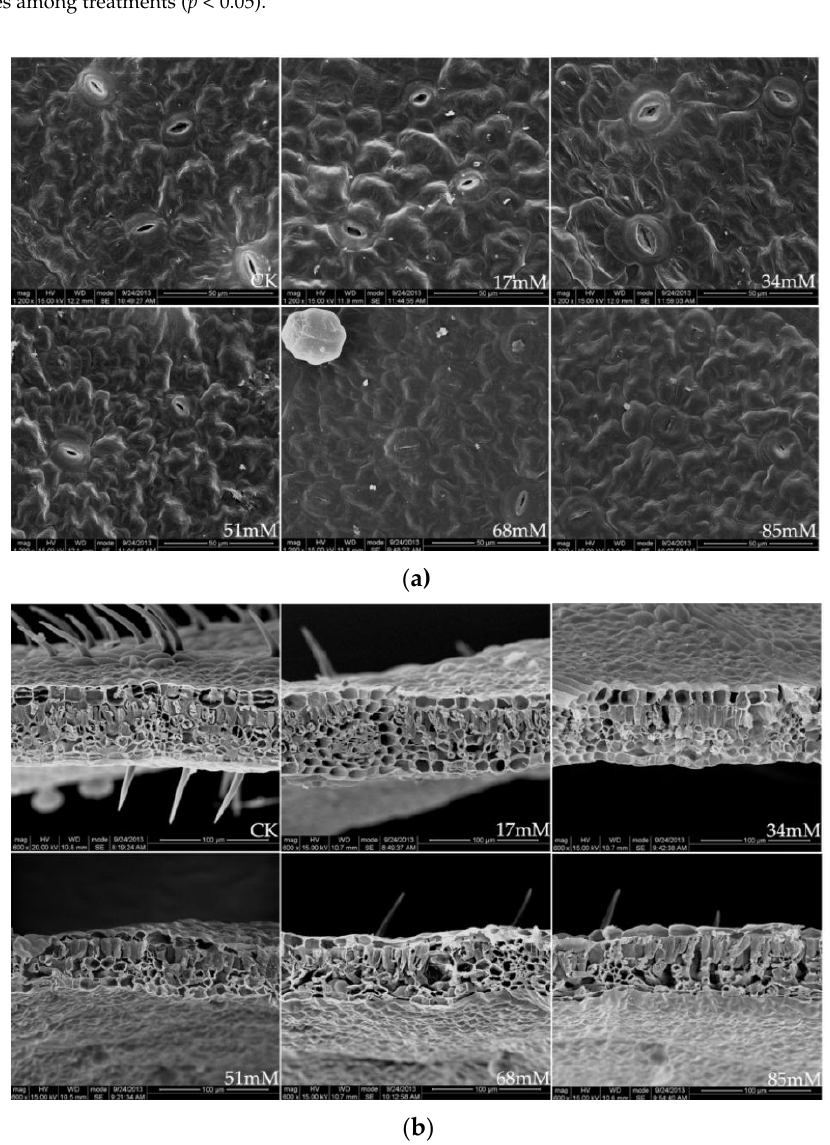
Figure 1. Stomatal structure on the leaf surface ( a ), × 1200, and leaf cross-section ( b ), × 600, of C. turczaninowii under salinity treatments.